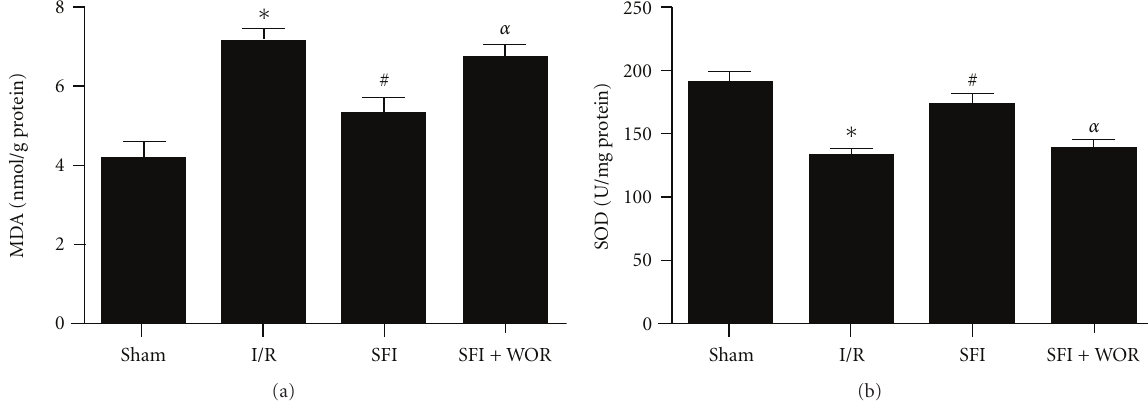
Figure 8: Malondialdehyde (MDA) and superoxide dismutase (SOD). I/R: ischemia/reperfusion; SFI: Shen-fu injection; WOR: wortmannin. Values presented are mean ± SEM. n = 6, ∗ P < . 05 versus Sham, # P < . 05 versus I/R, and α P < . 05 versus